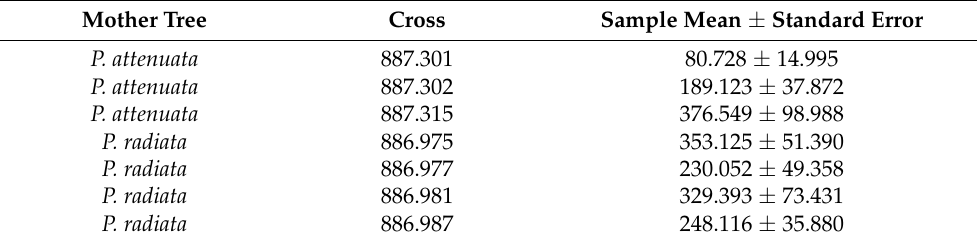
Table 2. Number of somatic embryos g − 1 fresh weight in embryogenic cell lines in which P. attenuata acted as the mother tree (crosses 887.301, 887.302, 887.315) and in which P. radiata var. cedrosensis